Question: What type of chart is this?
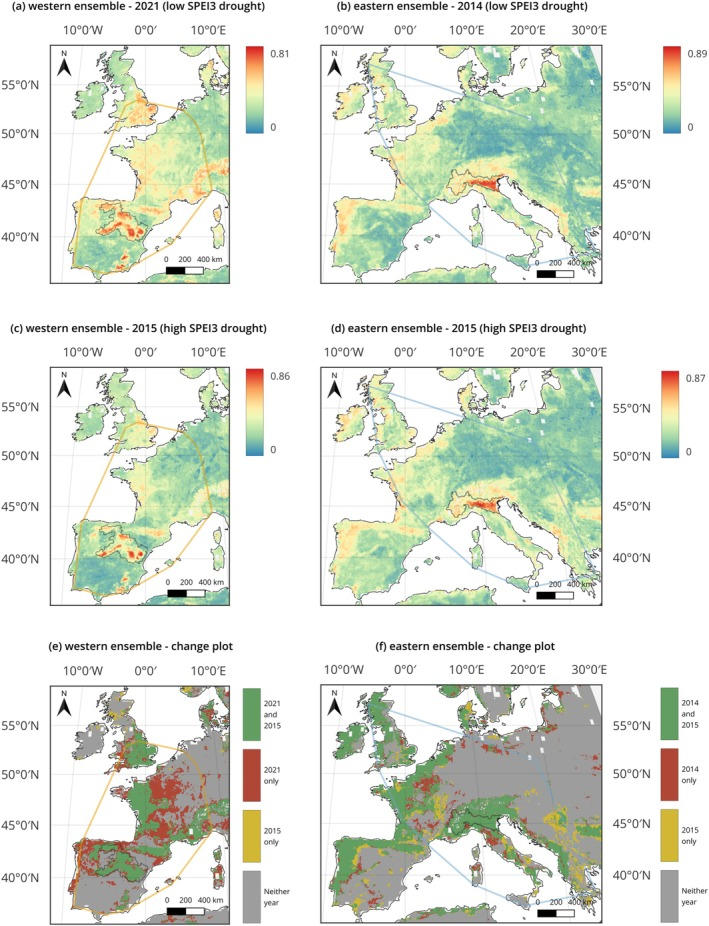
Answer: heatmap